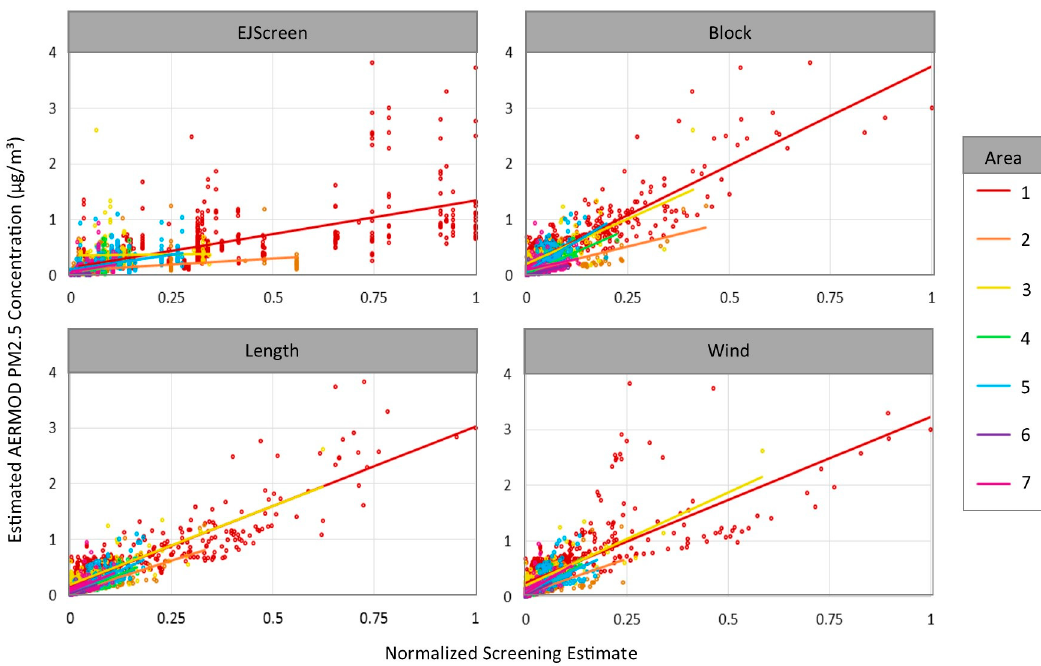
Figure 4. PM 2.5 concentrations versus normalized roadway air pollution screening indices.